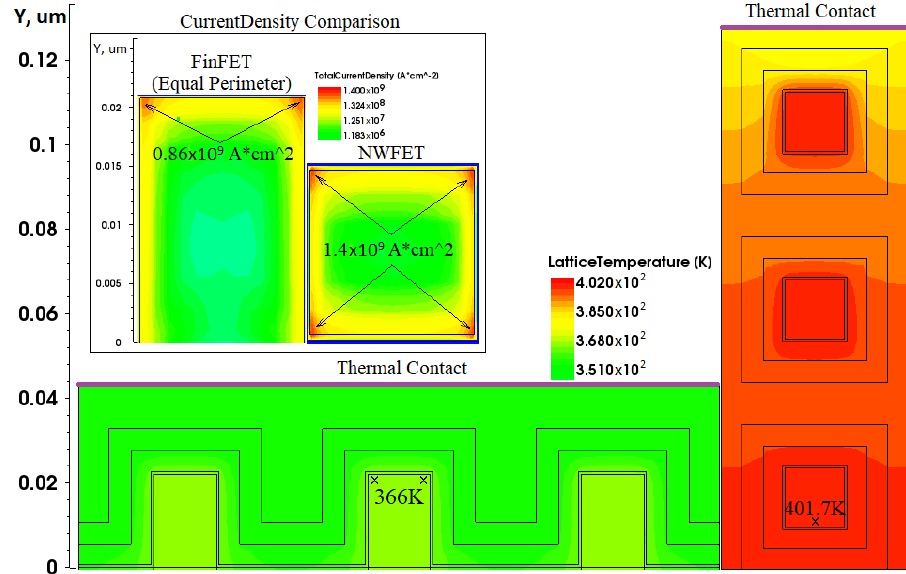
Figure 13. Comparison of the temperature distributions in 3-fin FinFET and NWFET